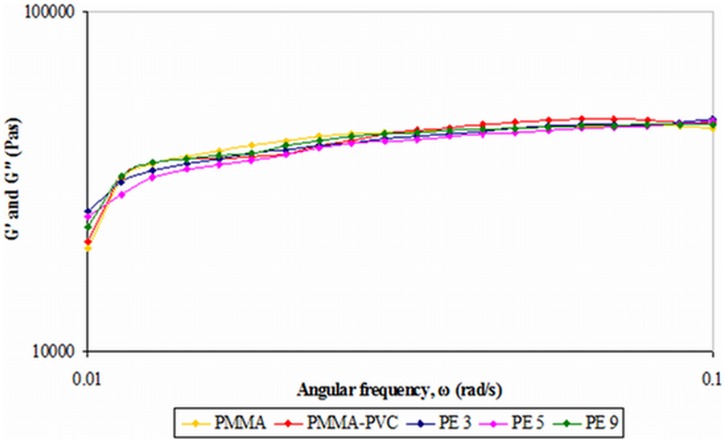
Frequency sweep of first system.